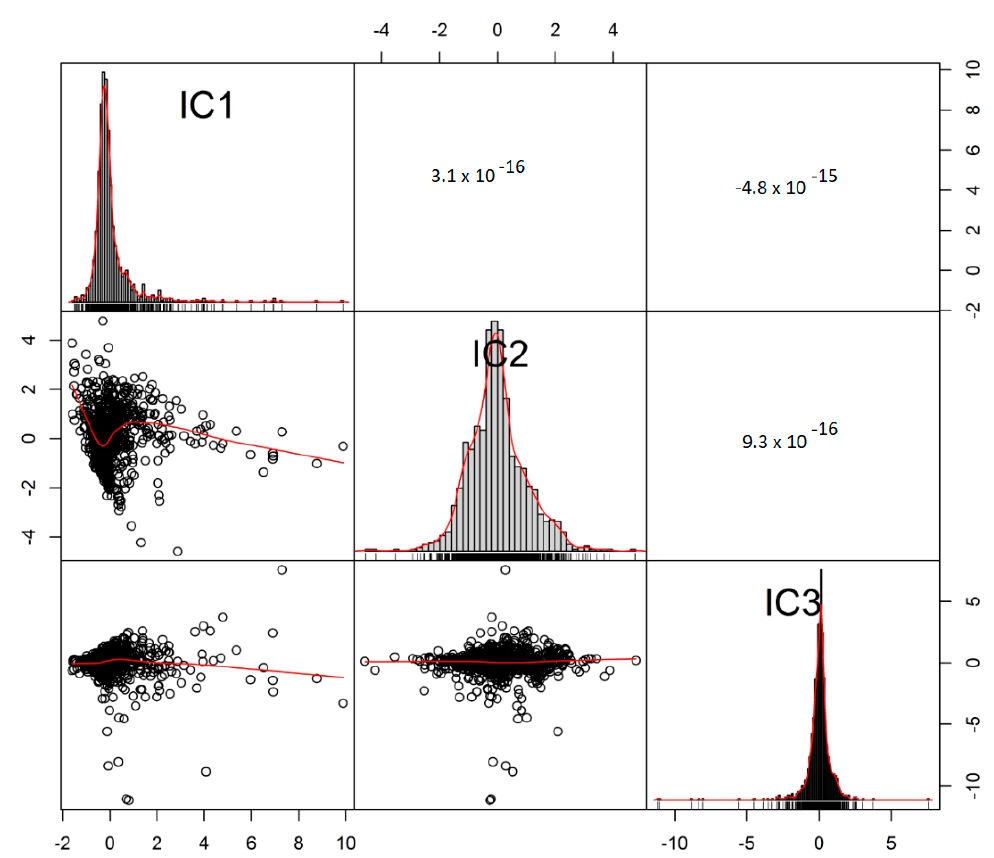
Figure 7. Correlation matrix plot showing a lack of correlation between the independent components.